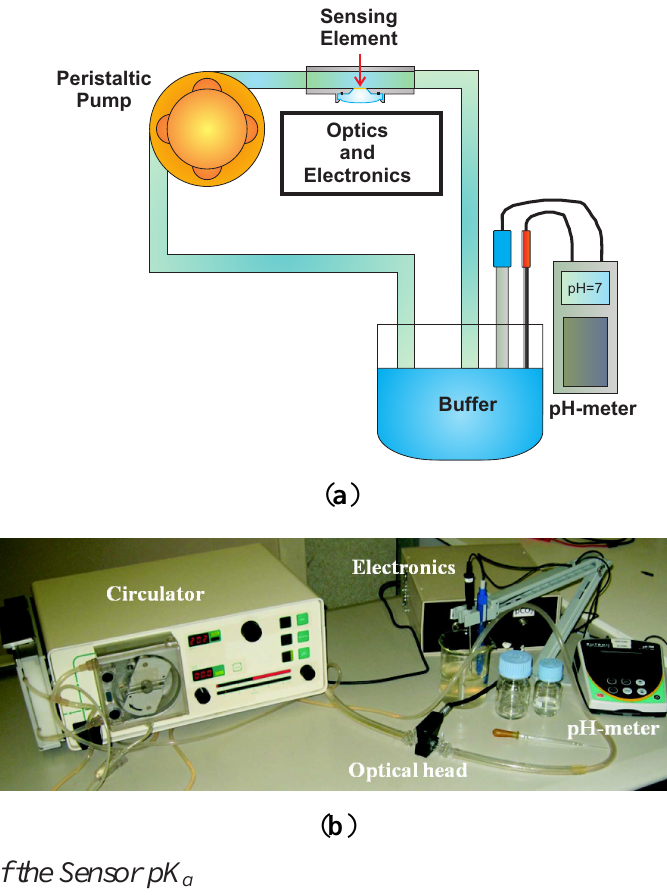
Figure 6. ( a ) Schematic representation of the fluidic system used to test the pH sensor. It consists of (i) a closed loop circulator, (ii) the optical head with the sensing element inside, (iii) a beaker with a reference glass electrode pH-meter to measure the pH of the solution and a thermocouple to measure the temperature of the solution and correct the pH value. ( b ) Picture of the fluidic system used to test the pH